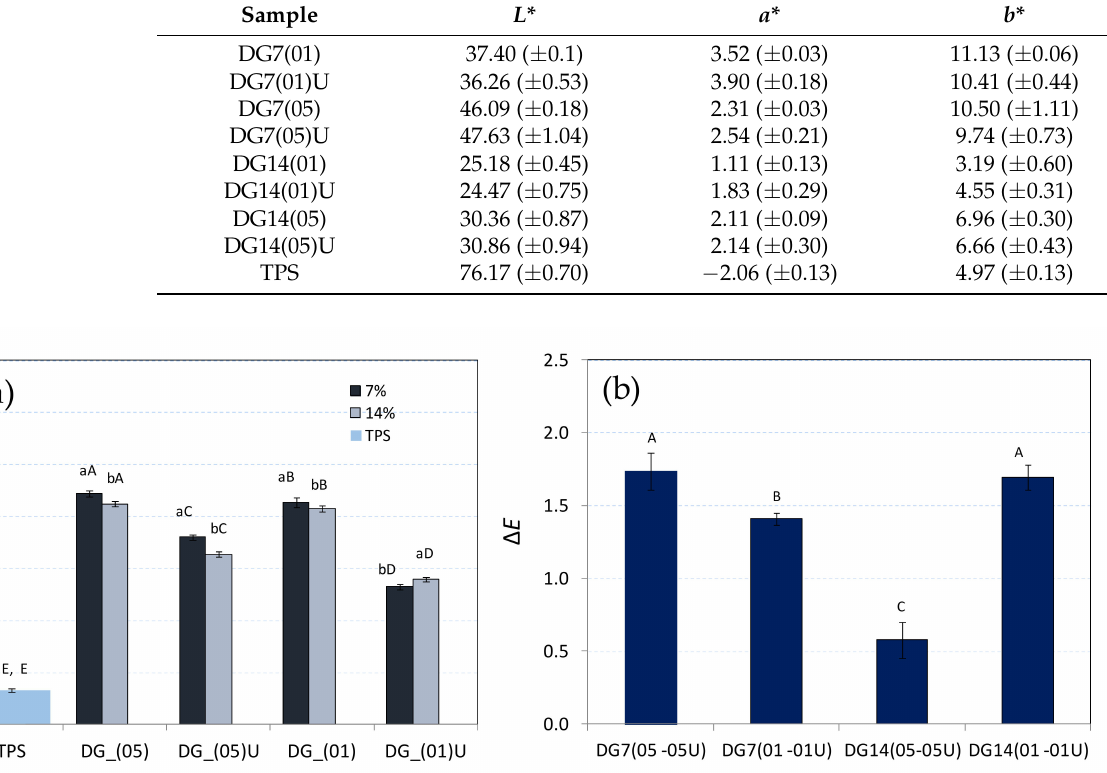
Figure 3. Contact angle charts and colour tests: ( a ) mean values of the changes in the contact angle. ( b ) Mean values of the difference in colour changes ∆ E between the digestate and the digestate not treated with